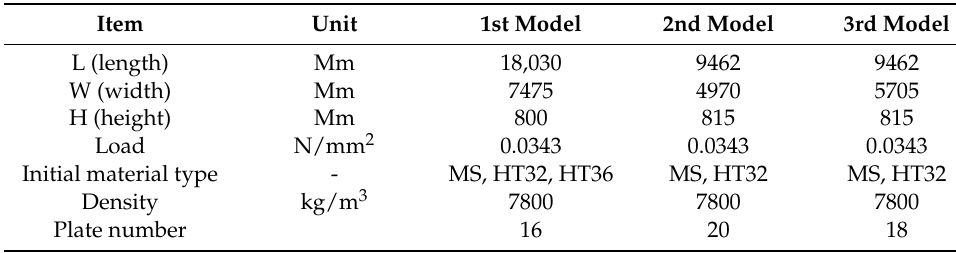
Table 3. Initial Table 3. Initial data.